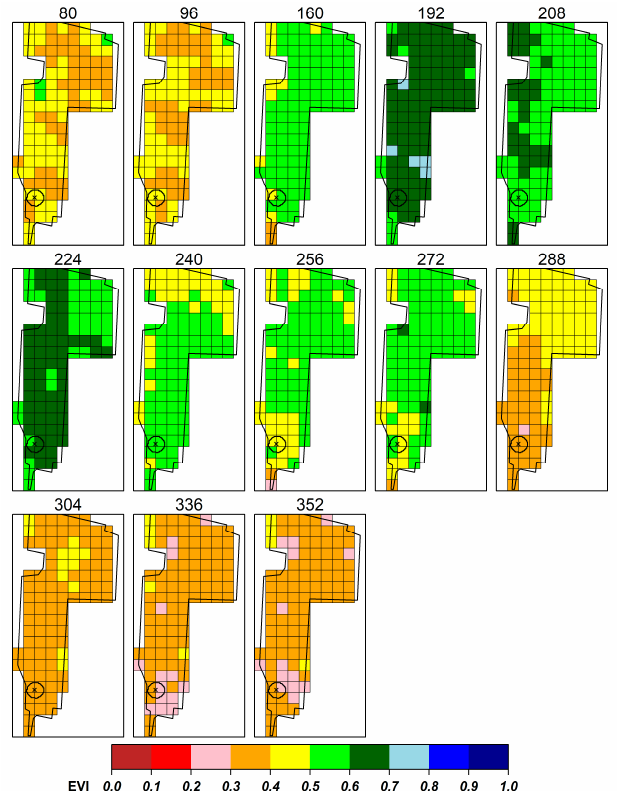
Figure 3. Enhanced Vegetation Index (EVI) for the whole vineyard in 2011 from 13 Landsat 7 images between DOY 80 and DOY 352. The cross shows the position of the EC system with the 80% footprint area.